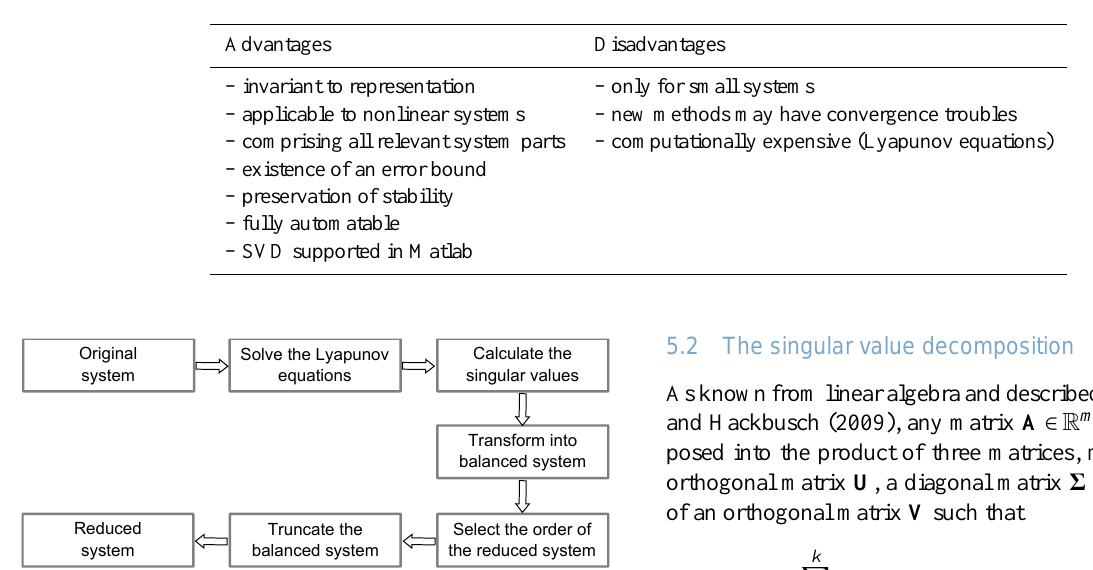
Table 3. Characteristics of SVD methods.